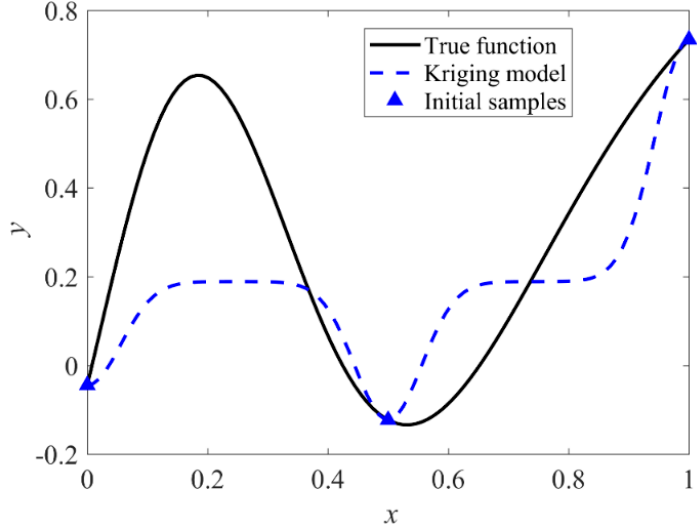
Figure 2. The initial Kriging model of the illustrated example.